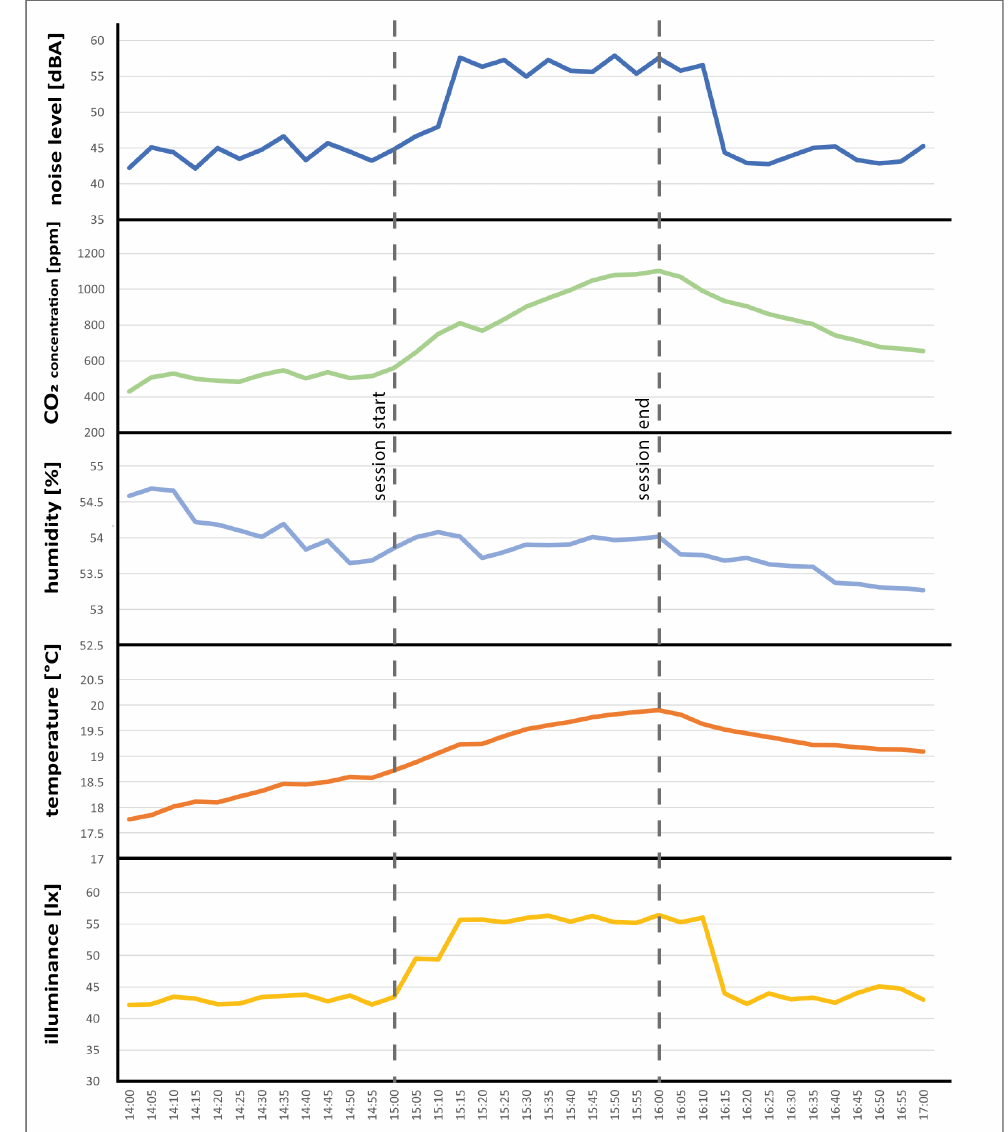
Figure 10. Measured physical parameters in a session